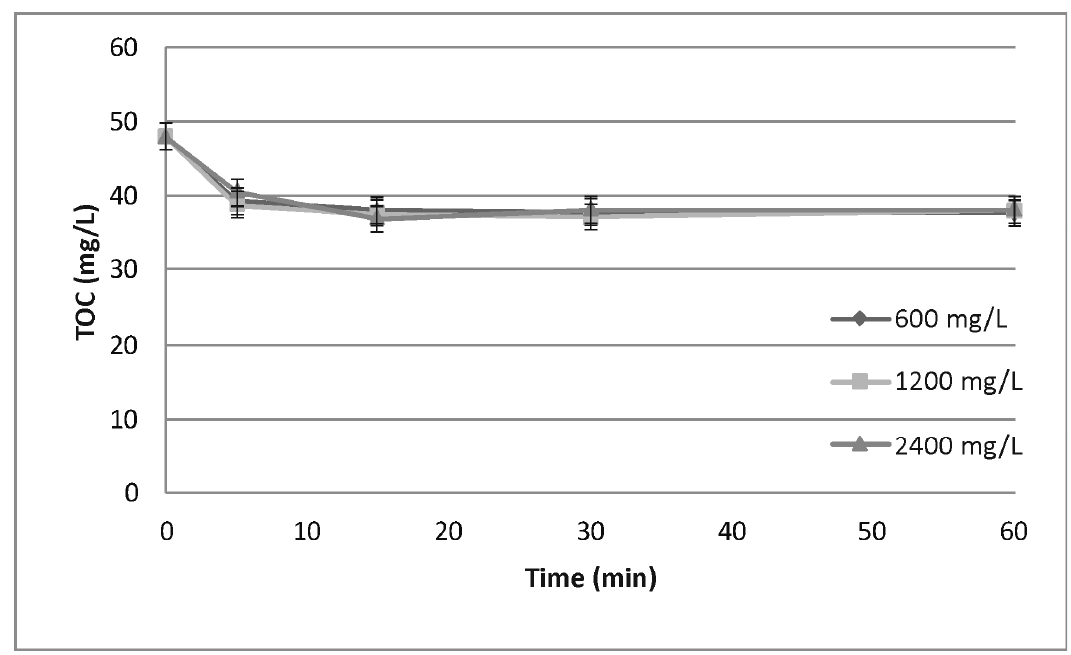
Figure 1. COD (chemical oxygen demand) removal in Fenton process: Fe 2+ dose 75 (mg/L), sedimented wastewater.